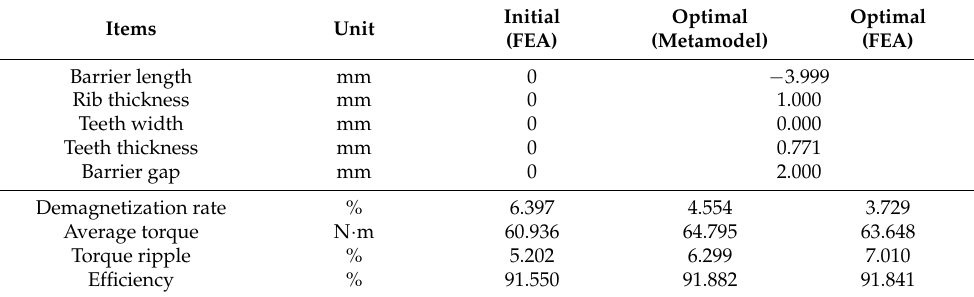
Figure 9. Change of multi-objective function according to weight change. Table 5. Optimization results.